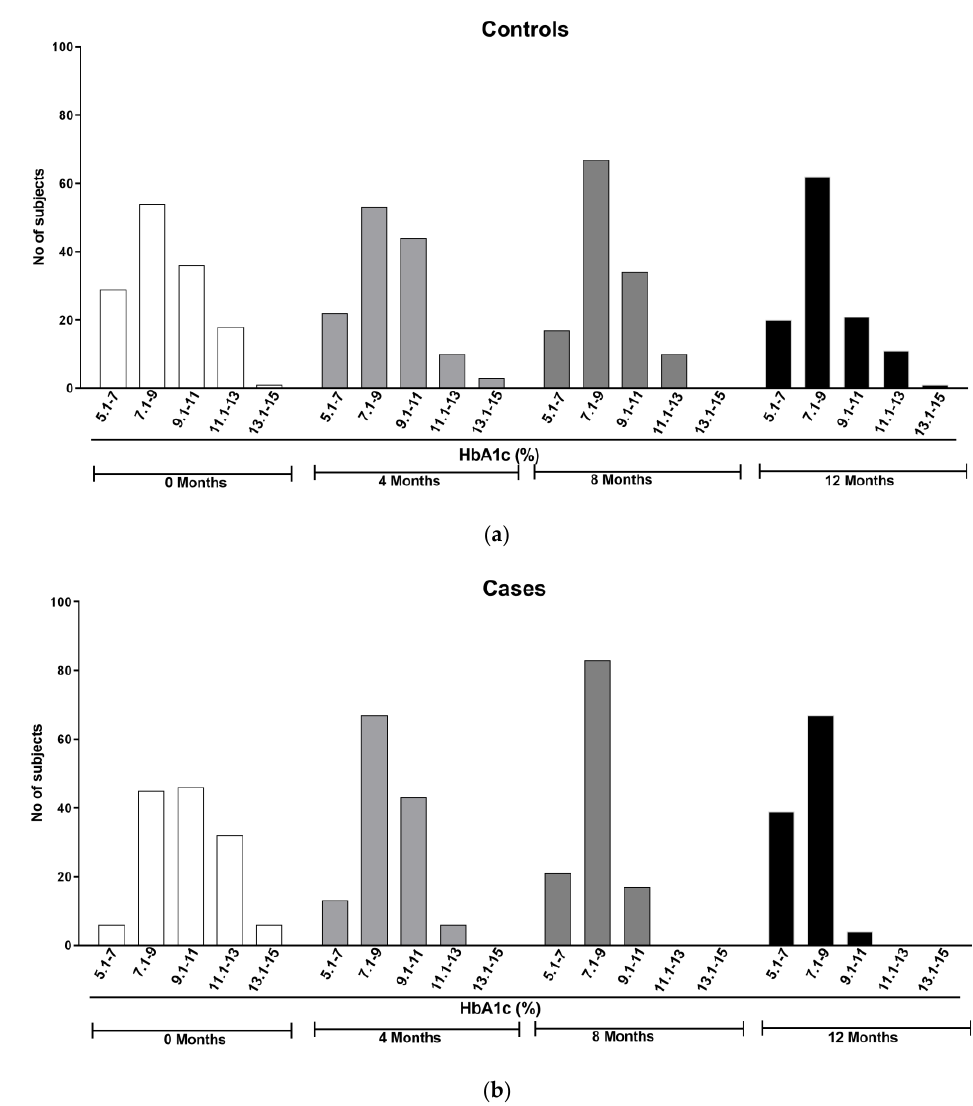
Figure 6. ( a , b ): Comparison of HbA1C values among the control and case groups across the study period. Providing education through phone calls increased the number of individuals in the HbA1C range from 7.0 to 13.0 at baseline to 5.0 to 9.0 after 12 months of intervention. No such increase in the number of participants in the lower HbA1C range was observed in the control group, who had not received phone call-based education. The obtained data were significant especially in the range of HbA1C 7.0-9.0 in the case group ( p < 0.05; Tukey ’ s multiple comparison test).